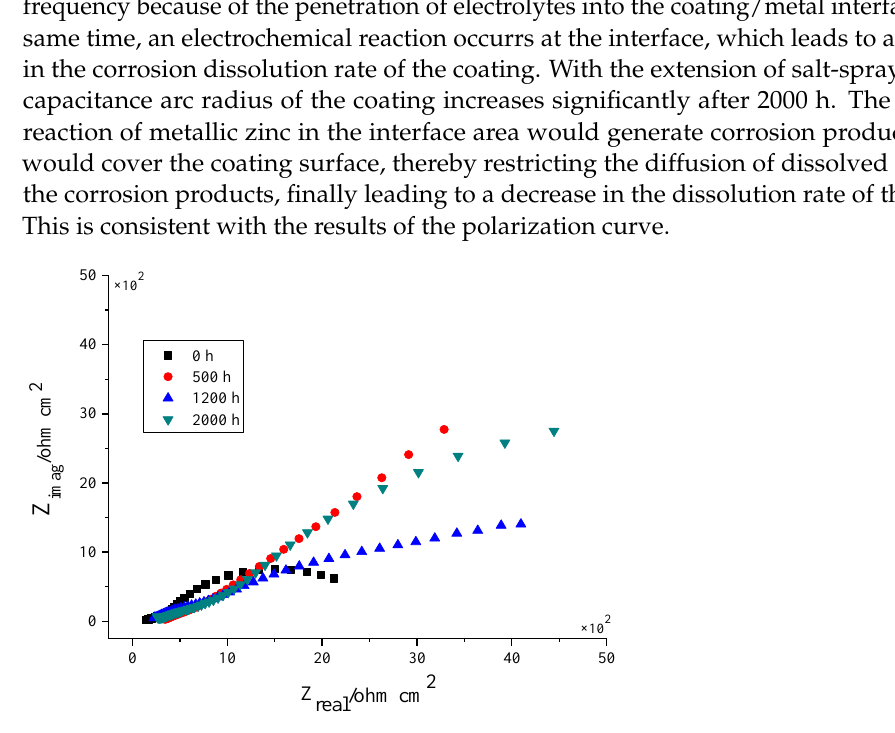
Figure 10. Nyquist charts of inorganic zinc-rich coating after being salt sprayed for 0–2000 h.